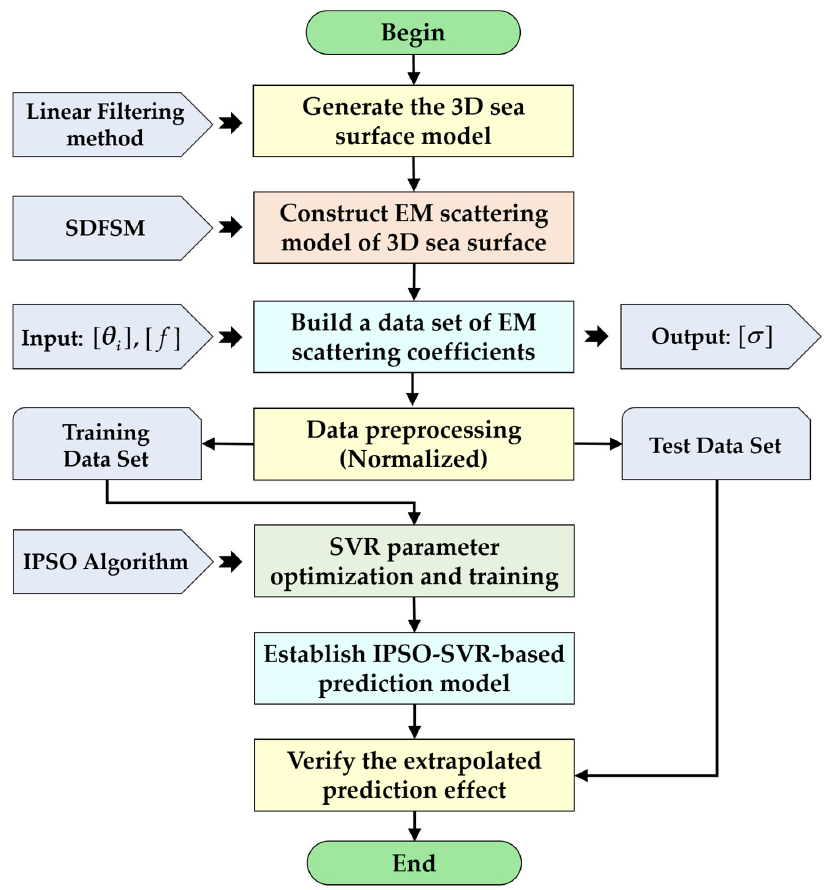
Figure 6. Flowchart of the IPSO-SVR-based model for 3D sea surface backscattering coefficient pre- diction.